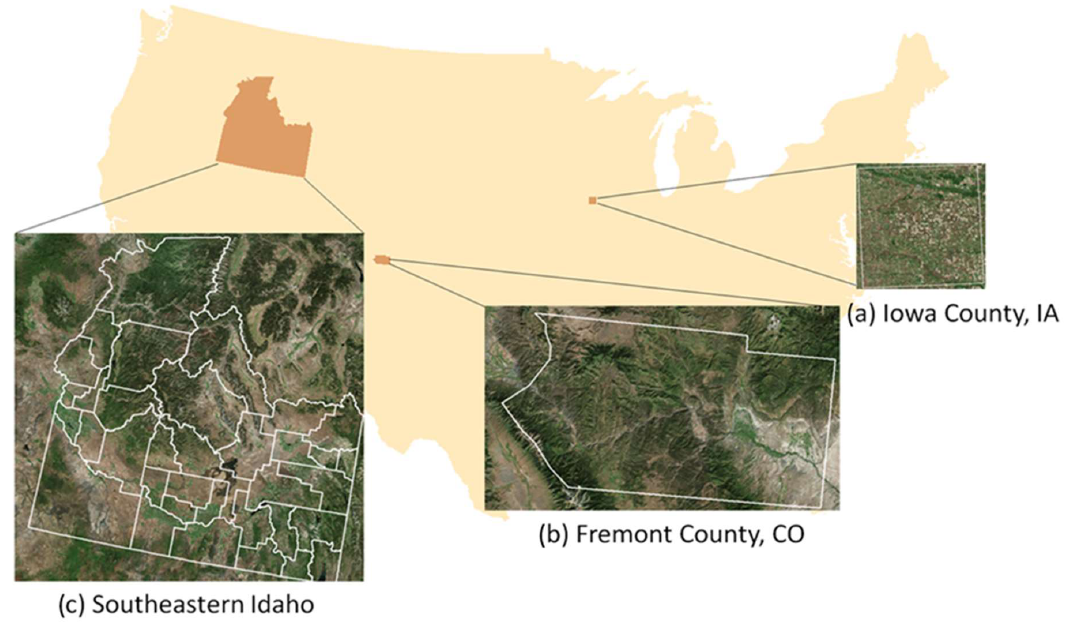
Figure 2. Selected area to represent three different landscapes: ( a ) flat land (Iowa County, IA); ( b ) mountain region (Fremont County, CO); and ( c ) mixed area (southeastern Idaho).